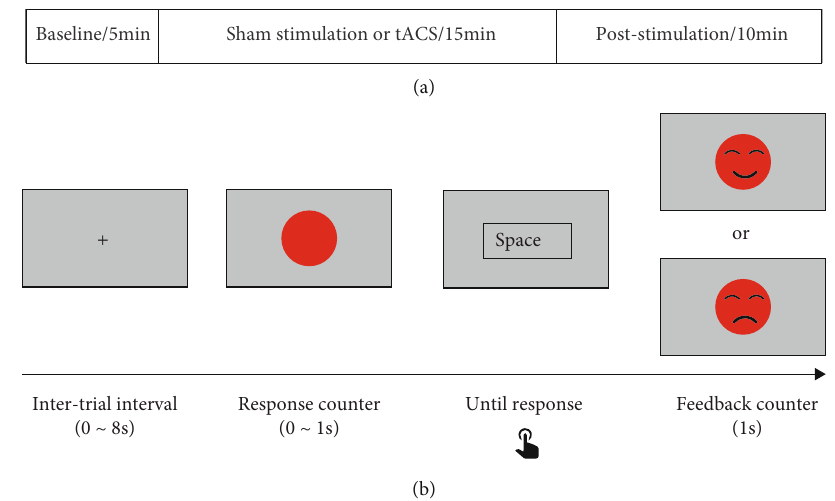
Figure 2: Schematic illustration of Experiment 2: (a) timeline of experiment events; (b) schematic illustration of one